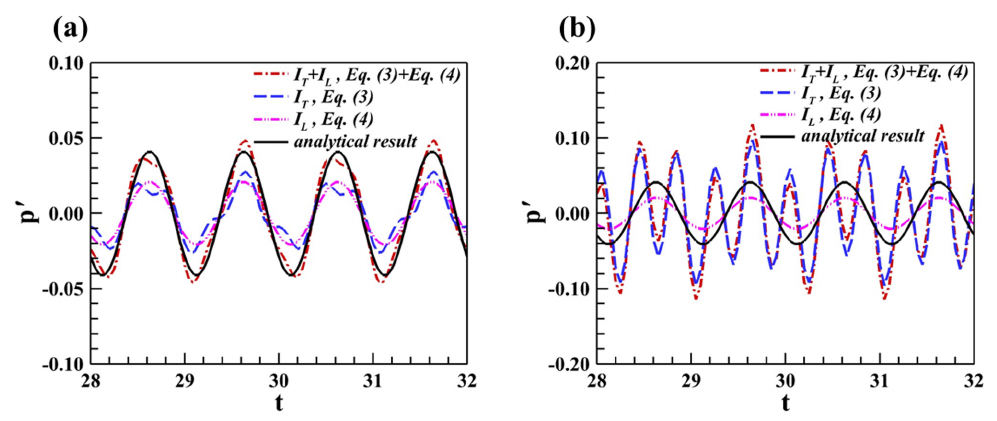
Figure 2. Acoustic pressure calculated by summing Equations (3) and (4) with spurious mass flux on the integral boundary corresponding to ( a ) A e = 10 − 6 m/s and ( b ) A e = 10 − 5 m/s. The far-field acoustic pressure computed by using the mass-conserved monopole term, Equation (8), is shown in Figure 3; the observer position is 100 c 0 ω 0 With the spurious mass flux filtered, the results show good agreement with the analytical solution for both cases. The maximum relative errors reduce to 0.2% and 1.8% at the peak of the acoustic pressure